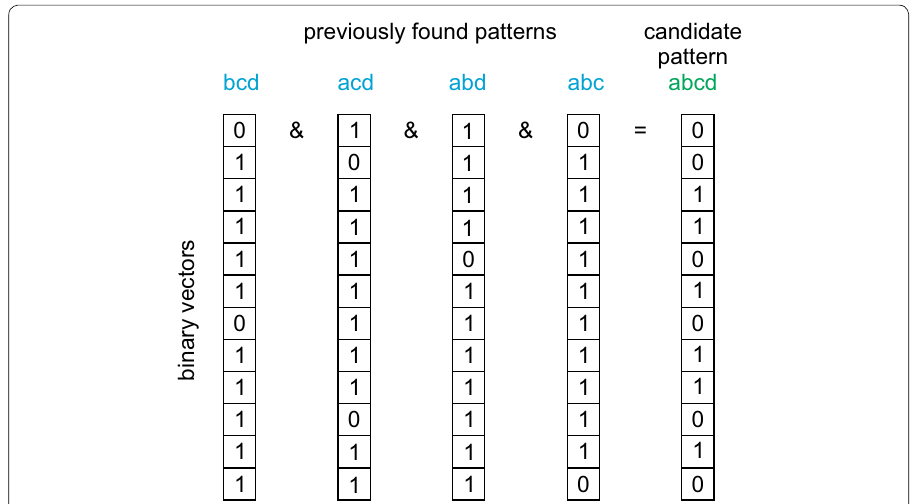
Fig. 3 Binary candidates for sequence (cid:31) a , b , c , d (cid:30) as a product of binary vectors for sequences (cid:31) b , c , d (cid:30) , (cid:31) a , c , d (cid:30) , (cid:31) a , b , d (cid:30) and (cid:31) a , b , c